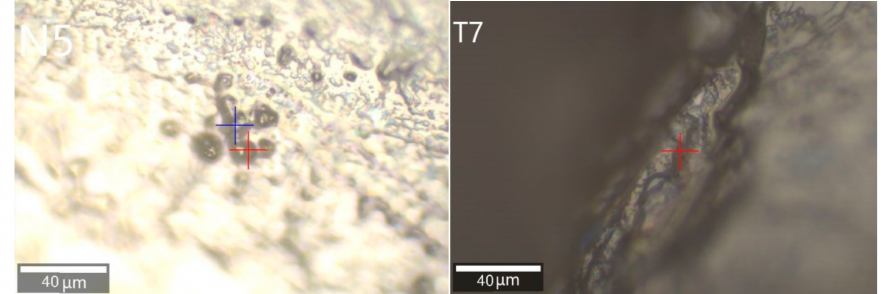
Figure 6. Location and morphology of anatase inclusions in tanzanite samples N5 and T7.